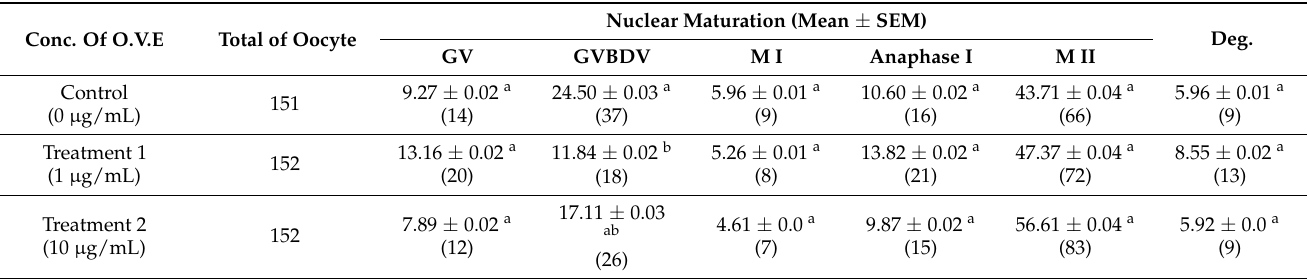
Table 2. The effect of the addition of O. vulgare extract on the rate of nuclear maturation of sheep oocytes matured in vitro.